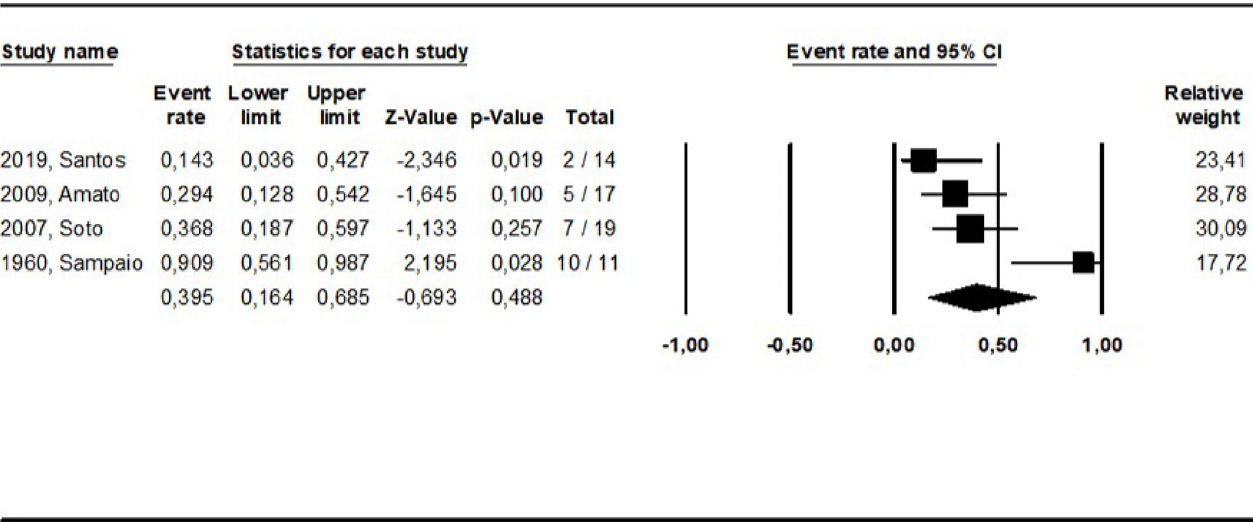
Fig 4. Pooled cure rate including all patients treated with deoxycholate amphotericin in the reviewed studies.